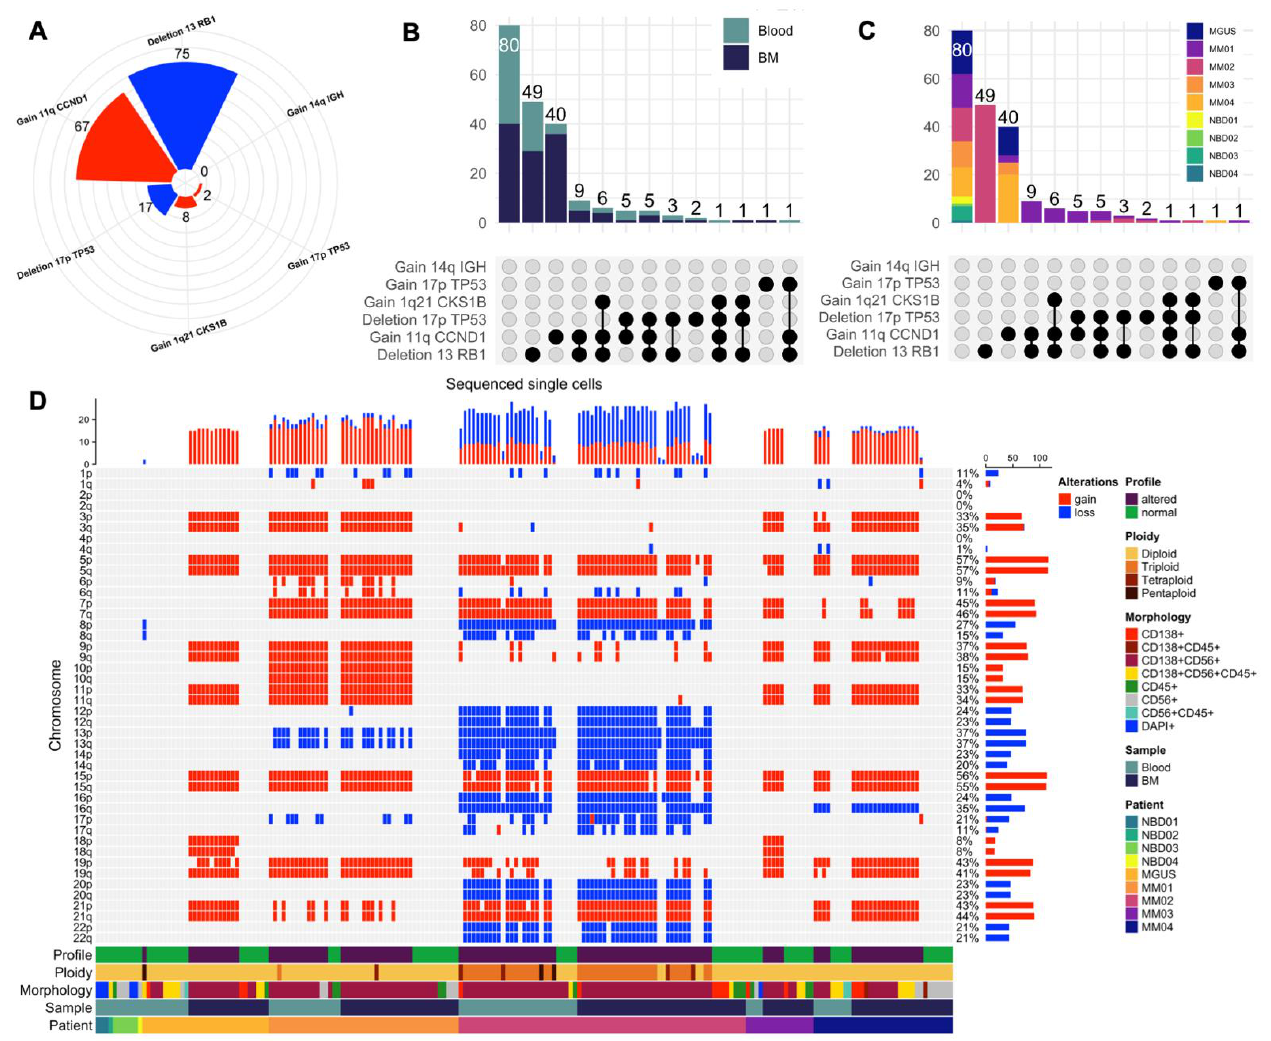
Figure 5. Correlation of scCNV events with diagnostic cytogenetic aberrations for clinical validation. ( A ) Intersect analysis mapping co-occurrence of FISH positive events in scCNV across PB and BMA samples. ( B ) Distribution of positive FISH events in scCNV across patients. ( C ) Enumeration of scCNV harboring indicated FISH cytogenetic aberrations observed across the patient samples. Blue = loss, ( D ) Chromosomal alterations across scCNV profiles of sequenced cells from all patient samples.